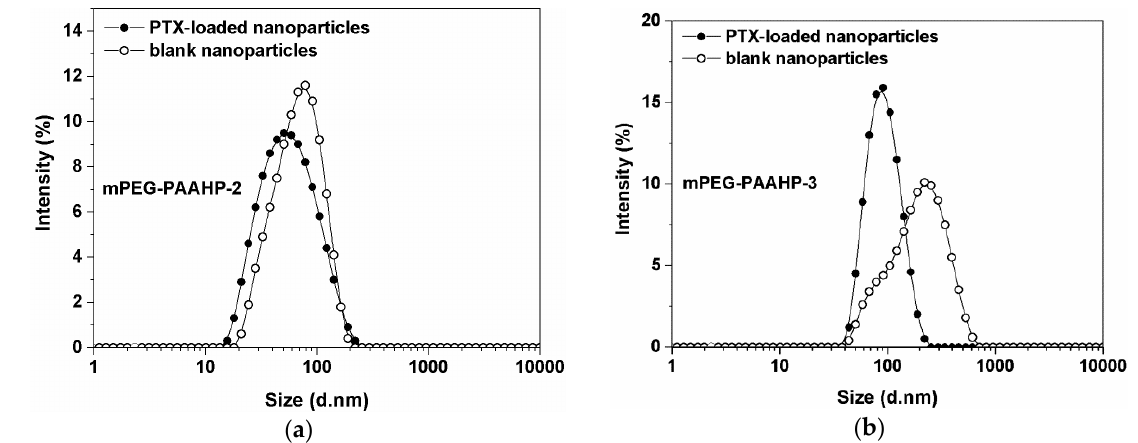
Figure 5. Diameters and size distributions of ( a ) mPEG-PAAHP-2 based blank nanoparticles and PTX-loaded nanoparticles (4.5%), and ( b ) mPEG-PAAHP-3 based blank nanoparticles and PTX-loaded nanoparticles (9.9%) in PBS buffer (pH = 7.4, ionic strength 0.15 M) at 37 ◦ C. mPEG-PAAHP concentration = 2.0 mg/mL.